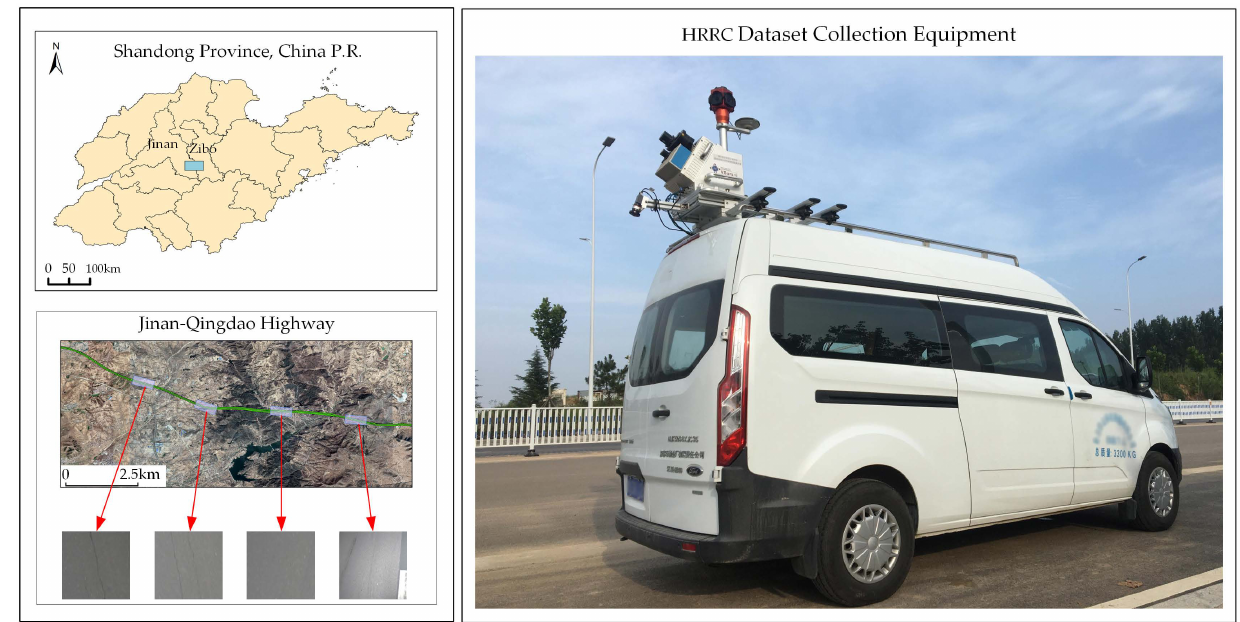
Figure 5. Geographical location distribution and collection equipment of the HRRC